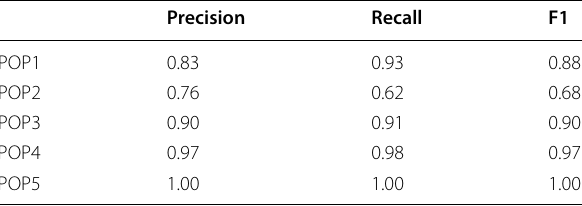
Table 4 The result of 10-fold cross validation based on 268 SNPs for population classification using Random Forest